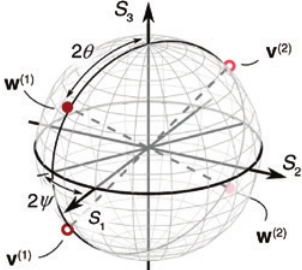
Figure 4: Illustration of the action of a 2d-chiral metasurface on the Poincaré sphere. w (1,2) and v (1,2) identify the polarization states of, respectively, right and left singular vectors of the transmission (Jones)